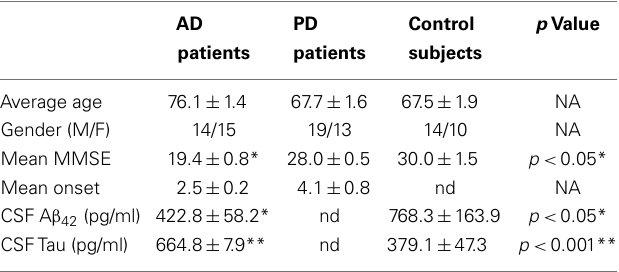
Table 1 | Demographic characteristics of patients with neurodegenerative diseases and control subjects